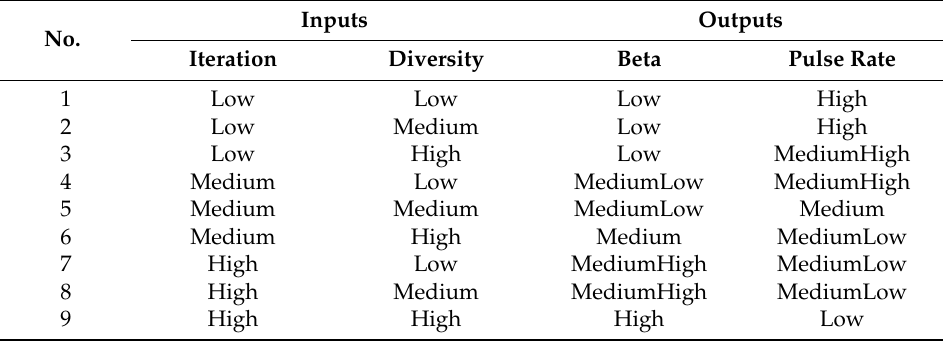
Table 3. Fuzzy rules for dynamic parameter adaptation in BA (Bat